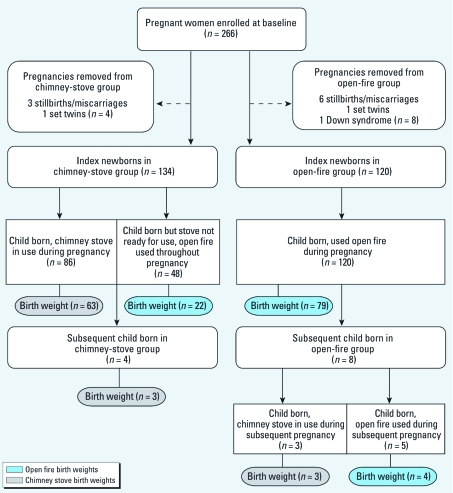
Study participants and total number of birth weights measured within 48 hr.